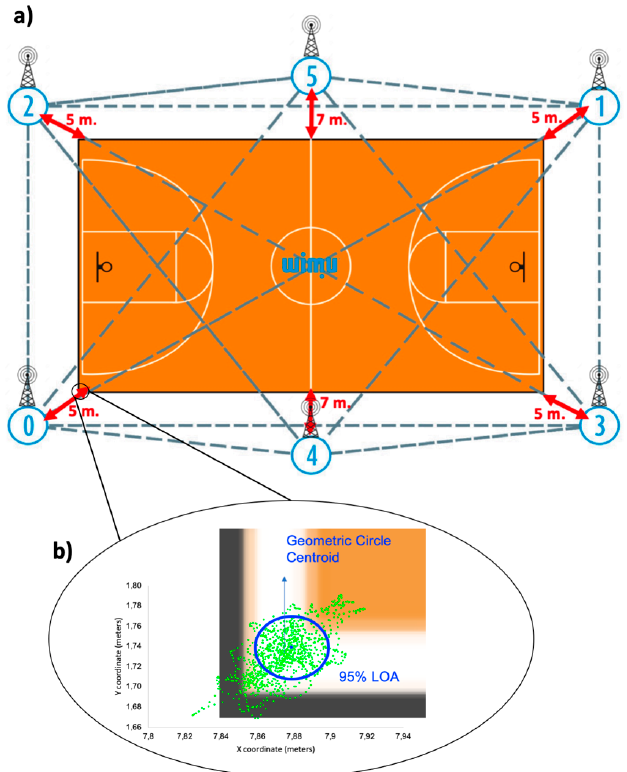
Figure 3. ( a ) Antenna distribution of the UWB system and distance reference to the basketball court. Red lines indicate distance from the antennas to the court and grey lines indicate communication between antennas. ( b ) Reference system process: (i) Four devices were placed in the corners of the basketball court and registered position data during 1´. (ii) Centroid data of the set of points obtained were calculated as the corner reference of the perimeter of the court. (iii) Finally, the routes designed with real measures (measured with a trundle wheel) were introduced in the generated